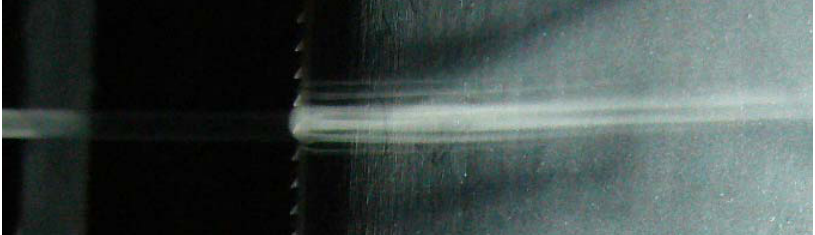
Figs. 8 Flow Field around an Airfoil with/without Different Serrations, at α =19 ° , U =1.5m/s